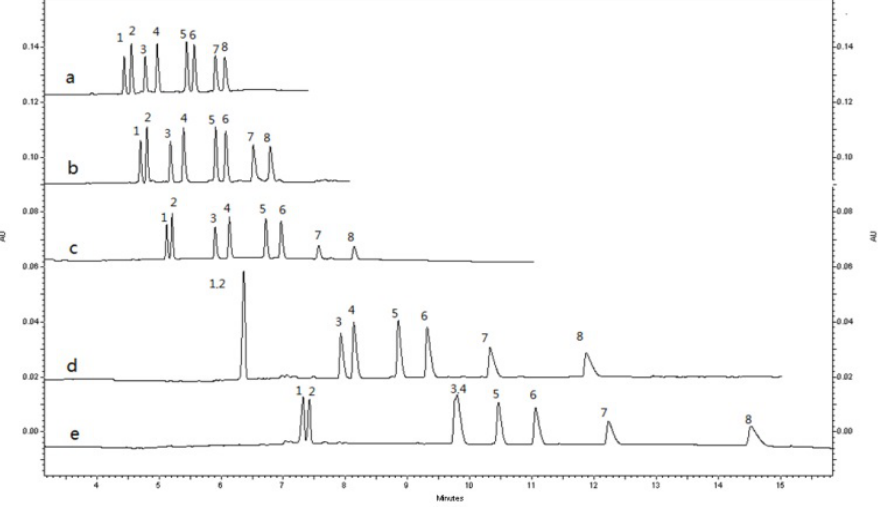
Figure 3. Electropherograms of rac -MRT(200 ng/mL) and its metabolites standard with different buffer pH: ( a ) pH 2.8; ( b ) pH 3.0; ( c ) pH 3.2; ( d ) pH 3.4; ( e ) pH 3.6. Peaks: (1) ( − )- R -DMR; (2) ( − )- R -MRT; (3) (+)- S -DMR; (4) (+)- S -MRT; (5) ( − )- R -8-OHM; (6) (+)- S -8-OHM; (7) ( − )- R -N-O-MRT; (8) (+)- S -N-O-MRT. Other conditions see Figure